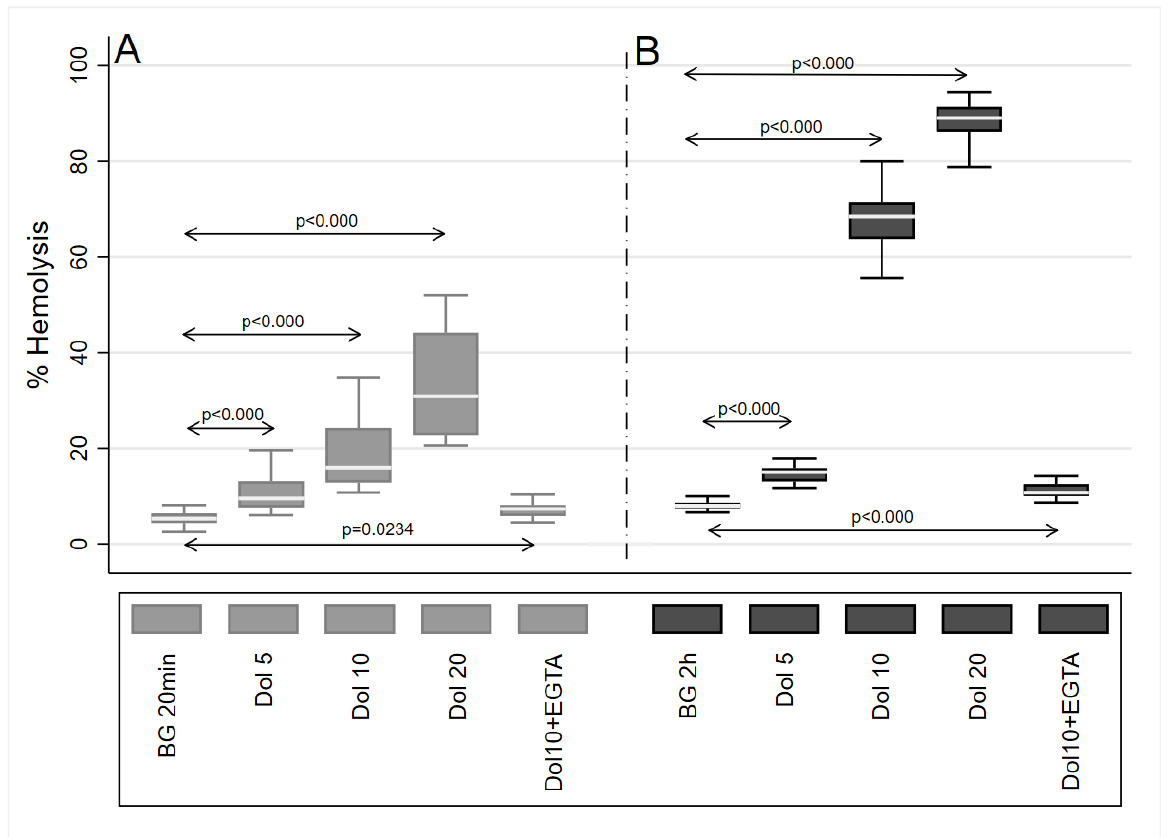
Figure 5. The hemolytic effects of dolutegravir (5–20 µ g/mL) at exposure times of 20 min ( A ) and 2 h ( B ), respectively. The results ( n = 3 donors with 5 replicates) are expressed as median percentage hemolysis in Box and Whisker plots.